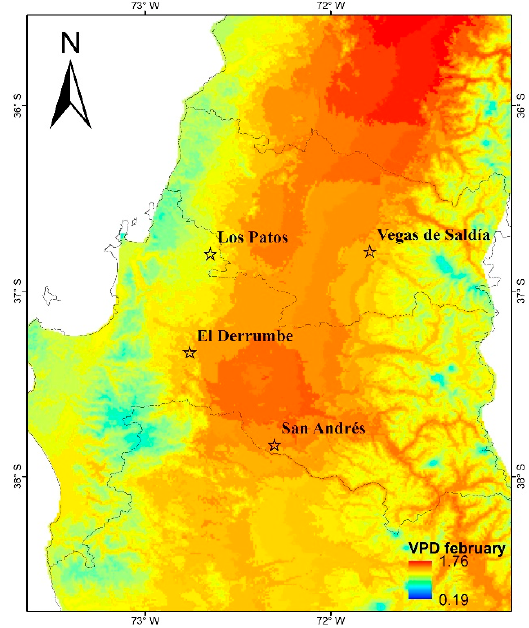
Figure 1. Mean daily vapour pressure deficit during the February summer month map representing the regional gradient in atmospheric water demand for all sites selected and genotypes within each